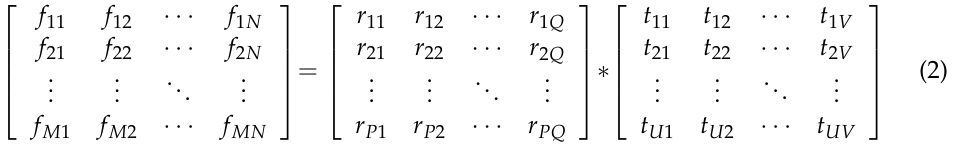
Figure 4. Schematic diagram of the material removal during plasma processing. Assuming that the number of original surface data points is M × N and the number of dwell time points is U × V, the material removal convolution equation can be converted into the matrix-based form as